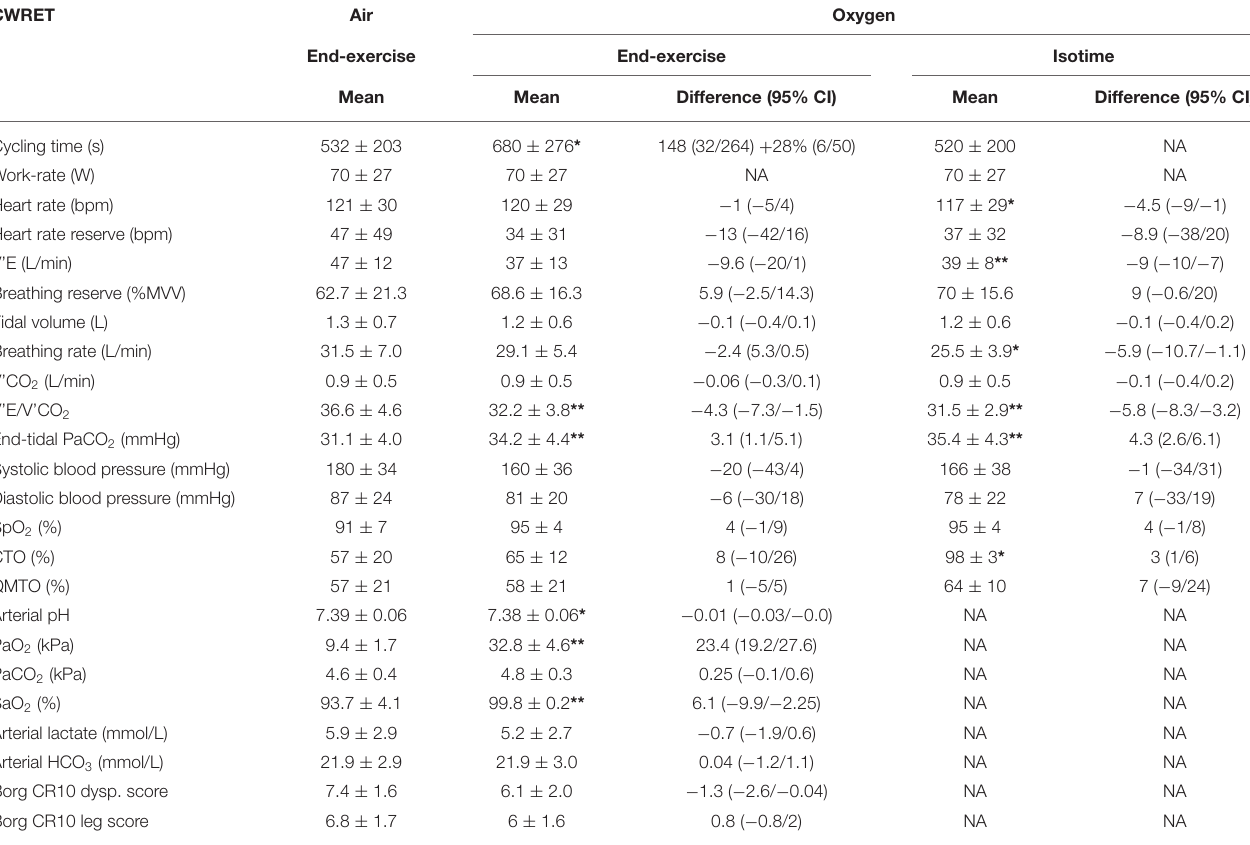
Values are presented as mean ± SD, n = 10. End-exercise represents the values averaged over the last 30s. Isotime refers to the identical time of end-exercise of the shorter test. MVV, maximal voluntary ventilation; SpO 2 ; pulse oximetry; CTO; cerebral tissue oxygenation; QMTO; quadriceps muscle tissue oxygenation; PaO 2 , arterial partial pressure of oxygen; PaCO 2 , arterial partial pressure of carbon dioxide; SaO 2 , arterial oxygen saturation; NA, not available. * p < 0.05; ** p <